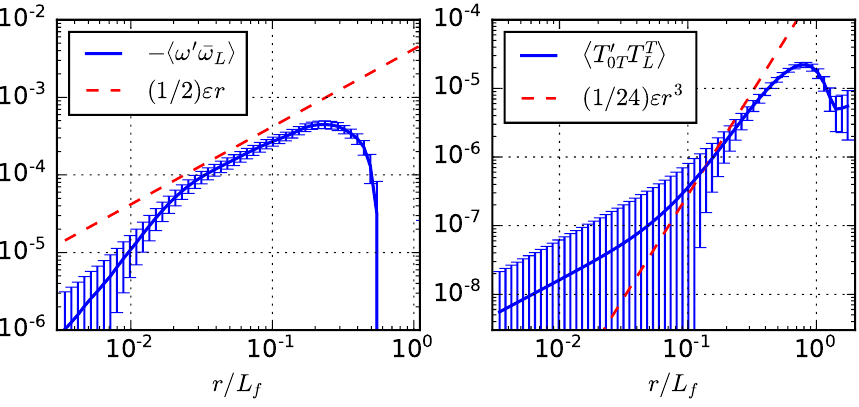
Figure 7 . (Left): the relativistic correlation function (cid:0) h ! 0 (cid:22) ! L i (blue, solid) plotted with its pre- diction in the direct-cascade range, (1 = 2) "r (red, dashed), as per eq. (2.8). The correlation function (cid:0) h ! 0 (cid:22) ! L i is (cid:12)t by (cid:24) r 2 : 24 at shorter distances and (cid:24) r 0 : 840 at larger distances, with the transition occurring near r=L f (cid:24) 2 (cid:2) 10 (cid:0) 2 . (Right): the relativistic correlation function plotted with its prediction in the direct-cascade range, (1 = 24) "r 3 (red, dashed), as per eq. (2.17). (cid:10) (cid:11) The correlation function T 0 T T is (cid:12)t by (cid:24) r 1 : 05 at shorter distances and (cid:24) r 2 : 40 at longer dis- 0 T L tances, with the transition occurring near r=L f (cid:24) 10 (cid:0) 1 . Error bars correspond to the statistical p uncertainty (cid:27)= N for each value of r=L f , where N is the sample size and (cid:27) is the sample standard deviation. Note that the statistical uncertainty at short distances is su(cid:14)ciently large that the